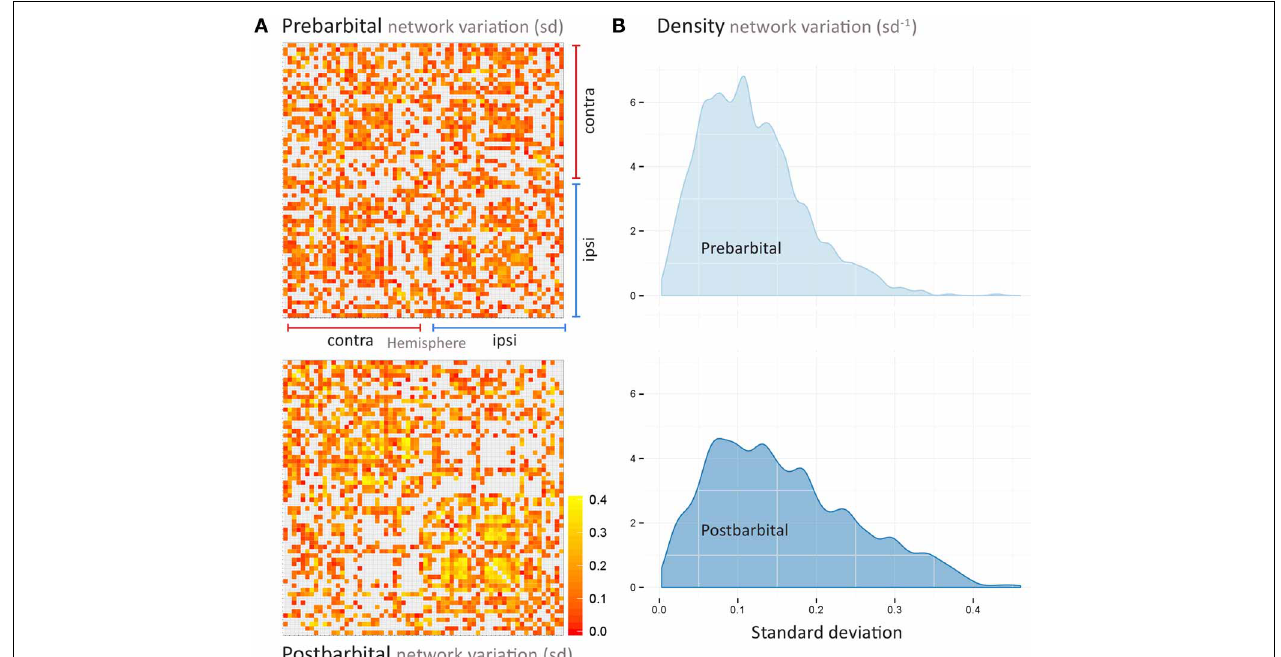
FIGURE 4 | Pre- and postbarbital (A) variation within the whole-brain functional connectivity matrices as shown in Figure 3. Each row and column represent a region-of-interest in the hemisphere ipsi- or contralateral to the side of cannulation. Matrix elements are colored according to the standard deviation ( SD ) of the individual functional connectivity values, measured as the correlation coefficient r between